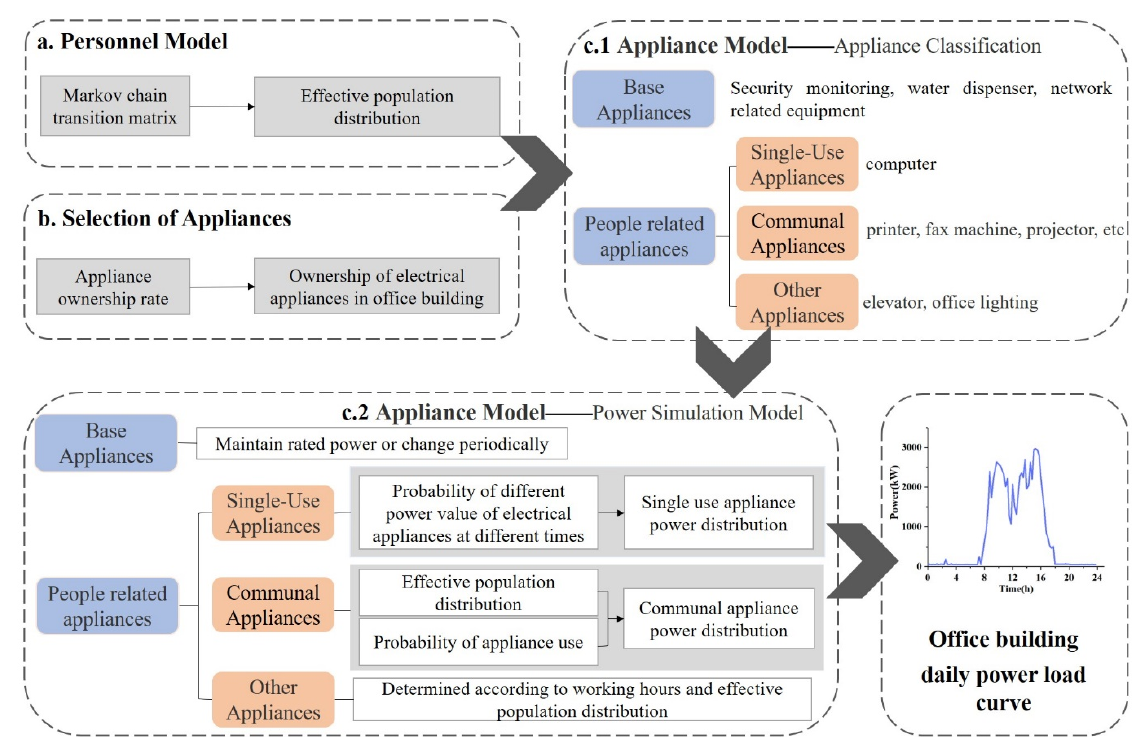
Figure 1. Bottom-up modeling system of daily electrical load curve for office building.